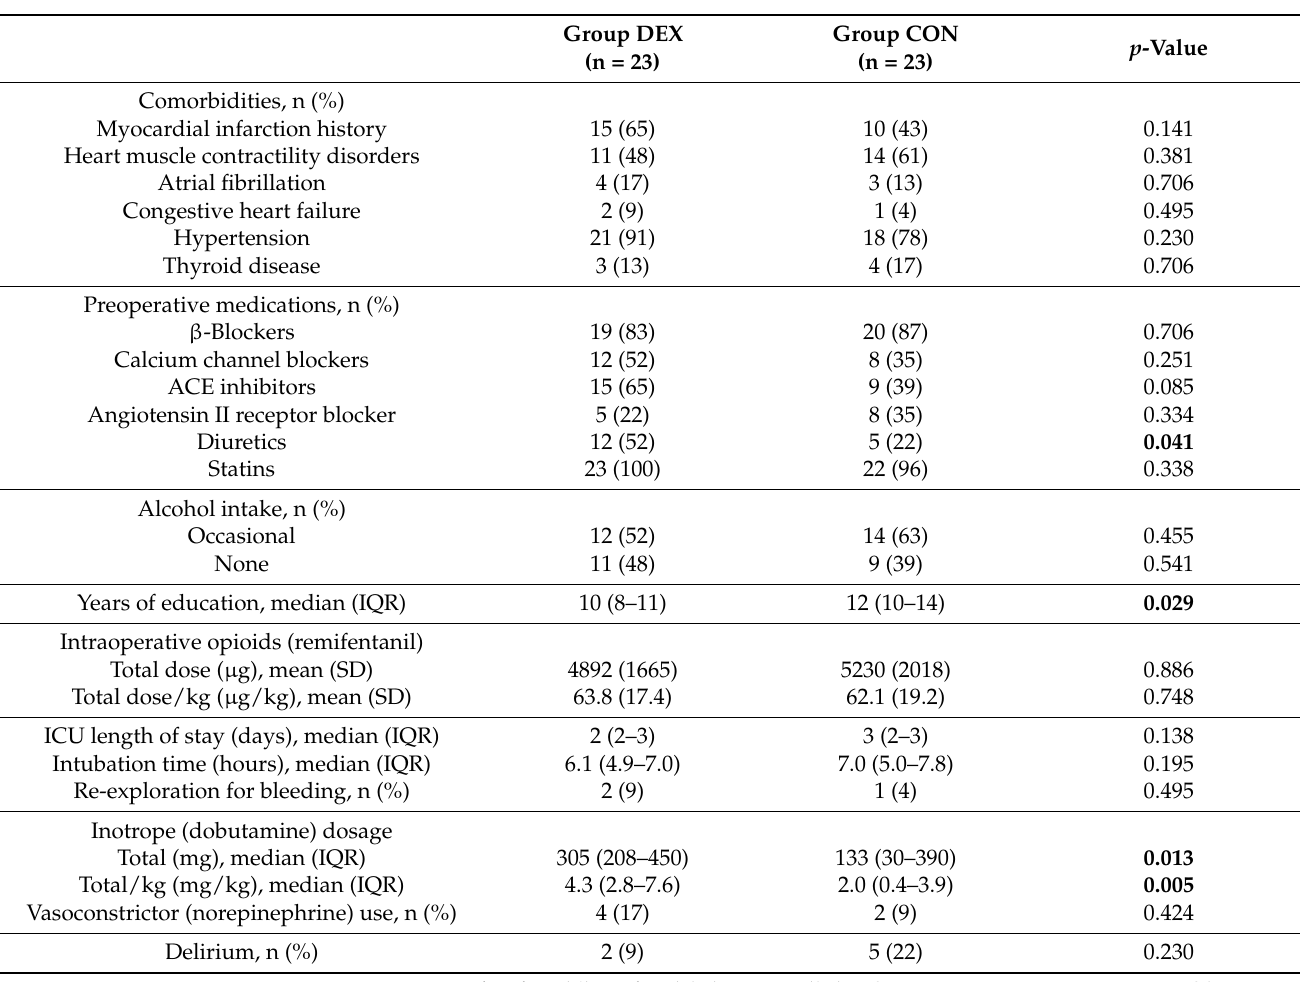
Table 2. Perioperative background